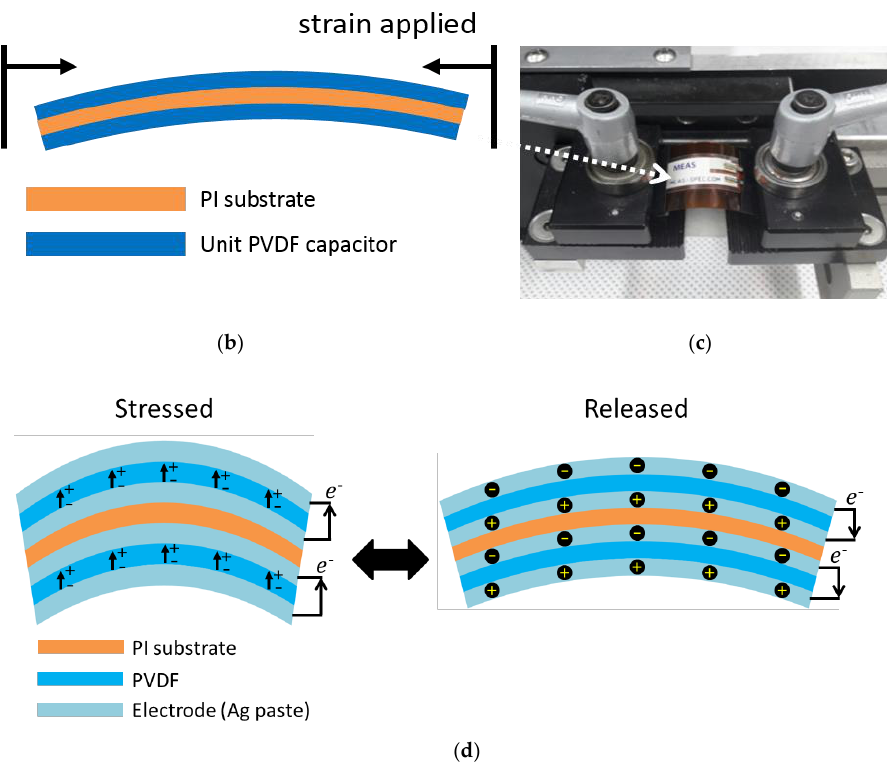
Figure 1. The test setup for piezoelectric PVDF’s fatigue measurement system ( a ) Unit PVDF capacitor with silver paste electrode and sealing layer ( b ) PVDF based piezoelectric generator device with PI substrate ( c ) The homemade servo motor-based bending system with controlled frequency and input displacement. ( d ) The unit PVDF capacitor based bimorph-shaped device with dipole arrangement inside the PVDF and electric flow.